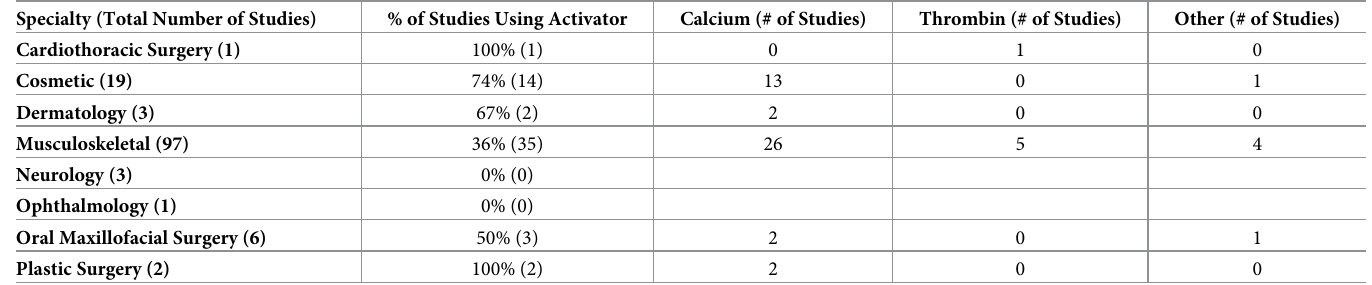
Table 3. Studies using an activator for platelet-rich plasma.